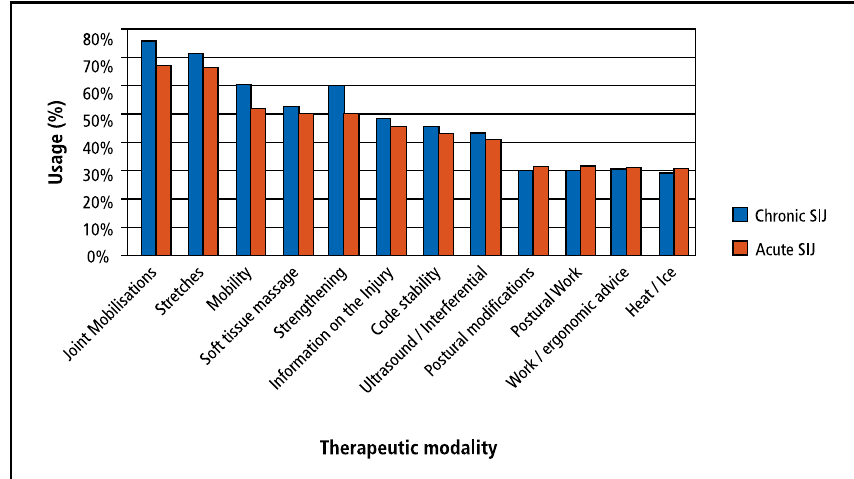
figure 1: Popular physical therapy modalities in the treatment of SiJ